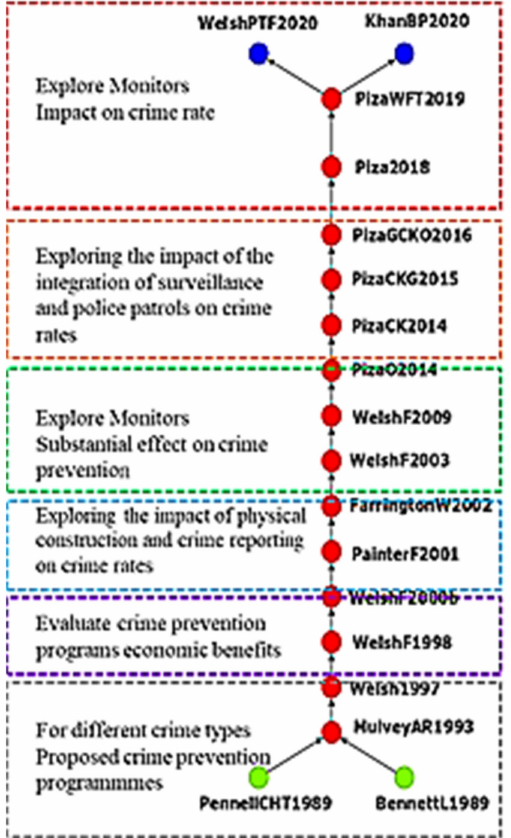
Figure 3. Main path analysis of crime prevention (Top to bottom). Exploring the effects of CCTV on crime rates. Exploring the effects of the combination of foot patrol and CCTV. Exploring the effects of CCTV on crime prevention. Exploring the effects of physical infrastructure and crime reports on crime rates. Evaluating the costs and benefits of crime prevention strategies. Proposing prevention strategies for various types of